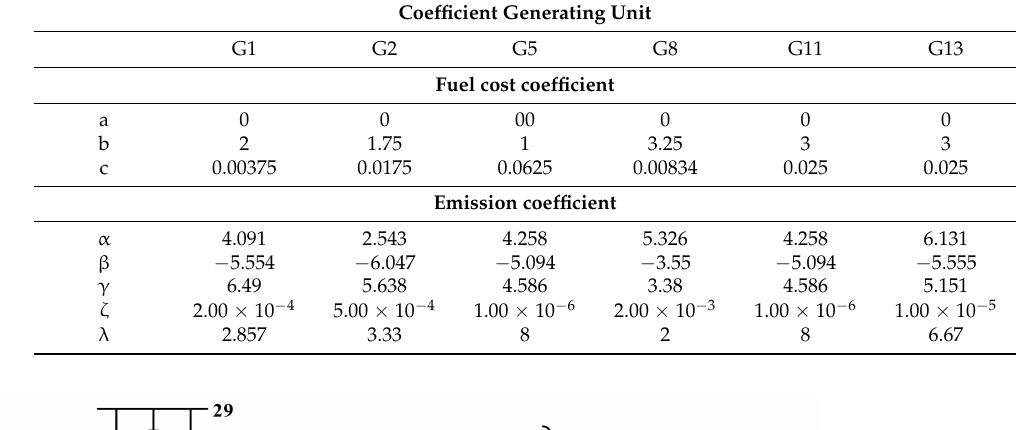
Table A1. The coefficients of cost and emission of generators for the IEEE 30-bus test system.